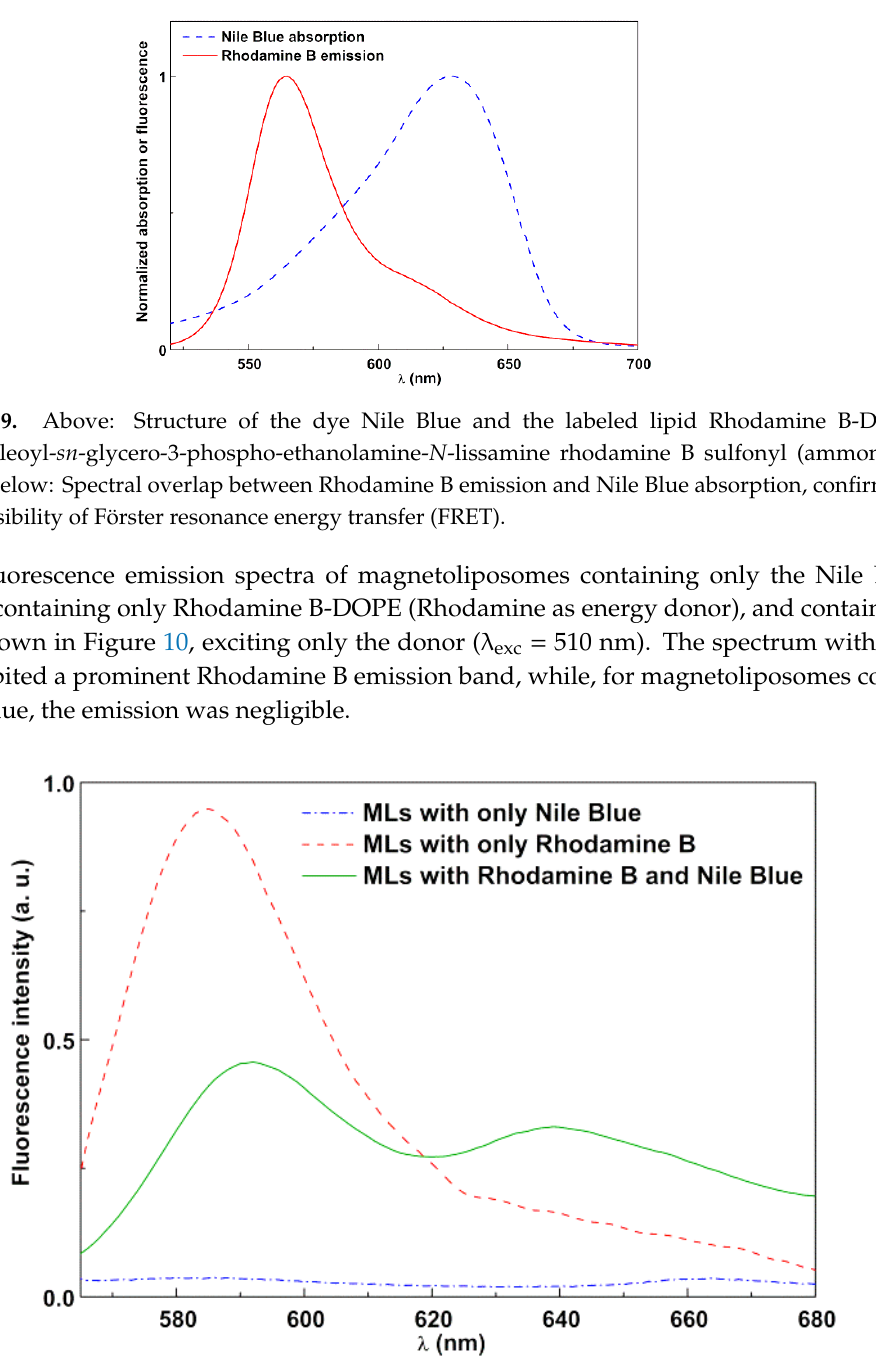
Figure 10. Fluorescence spectra ( λ exc = 510 nm) of magnetoliposomes (MLs) labeled with only Rhodamine B-DOPE, labeled with only Nile Blue, and labeled with both Rhodamine B-DOPE and Nile Blue.